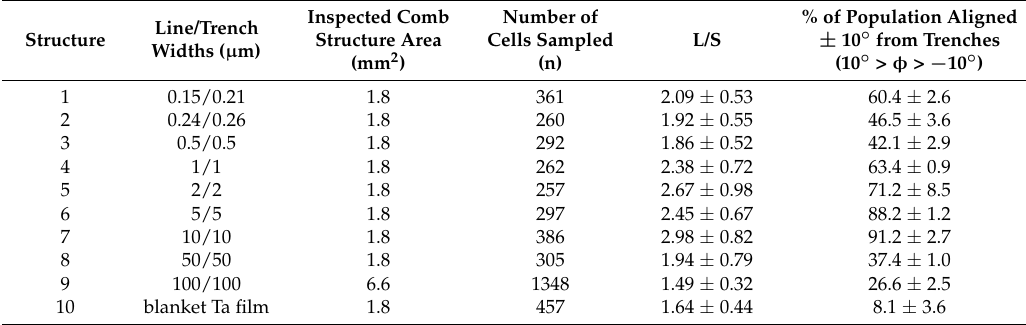
Table 1. A data summary of test structure dimensions, number of cells inspected (n), percent population of cells with 10 ◦ > φ > − 10 ◦ of the line axis, and axis length ratio (L/S). The culture media initial cell concentration used was ~0.5 × 10 5 cells/mL and cells were incubated on the comb structures for 24 h. Data spreads correspond to one standard